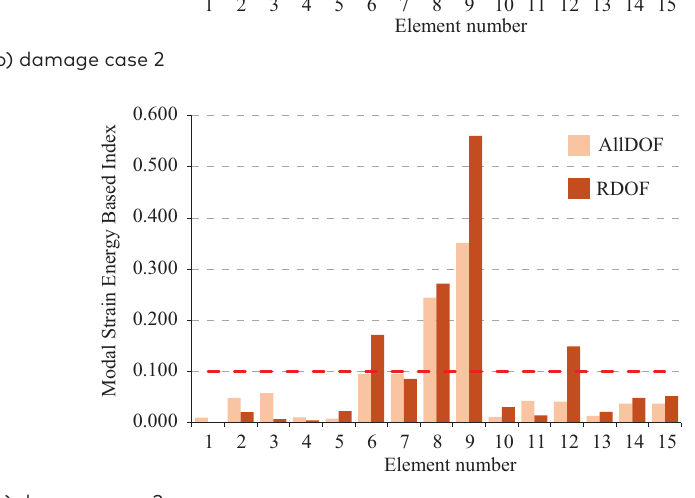
Figure 3. Damage index values in 15-element truss for three modes with 3%